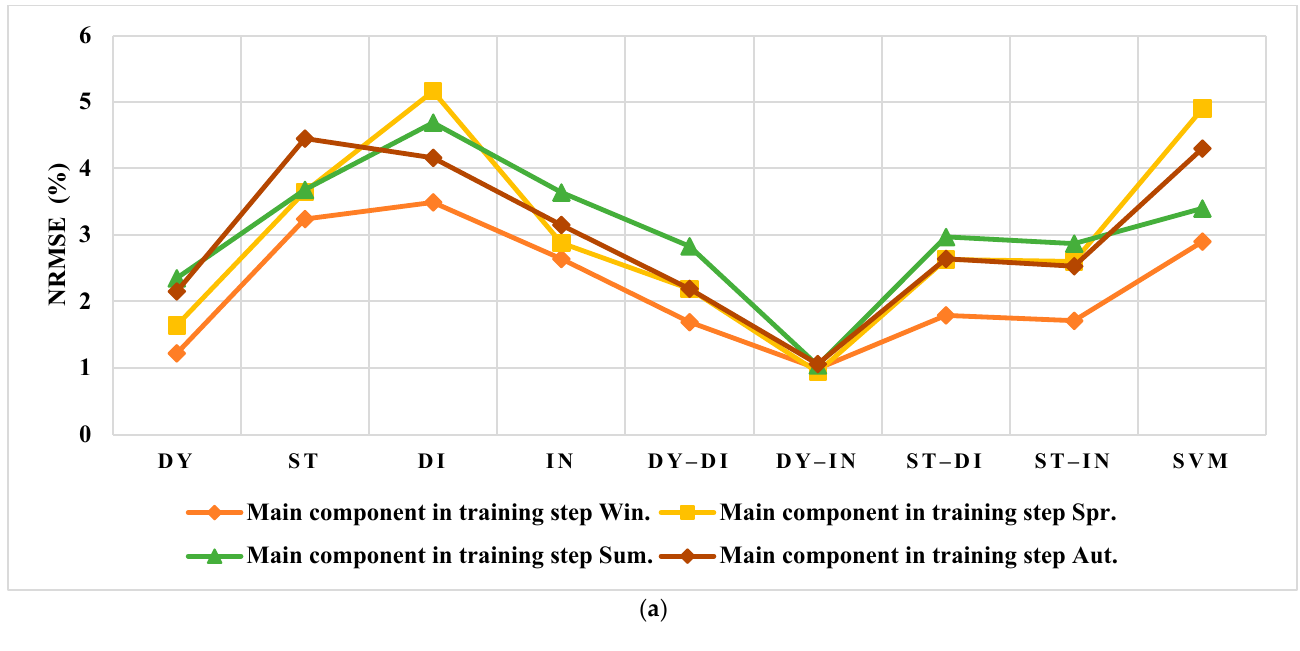
Main component in training step Win. Main component in training step Spr. Main component in training step Sum. Main component in training step Aut.